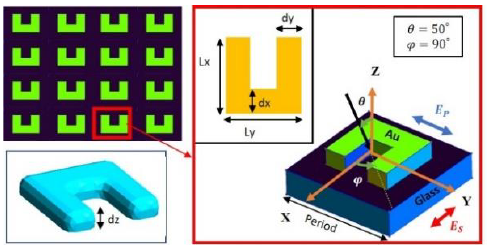
Figure. 1. Schematic of the meta-surface with U-shaped resonators with closer view of it at the inset. The parameters are (cid:31) = 232nm,(cid:31) = 210nm,# = 90nm,# = 74nm,# = 40%(cid:27), " " $ &’*-.# = 390%(cid:27). The corners of the U have been rounded off to avoid sharp resonances. The resonators are embedded in